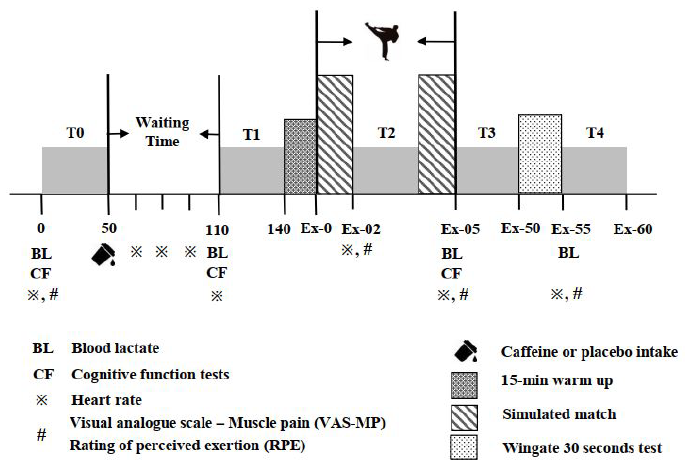
Figure 1. Illustration of experimental protocol.